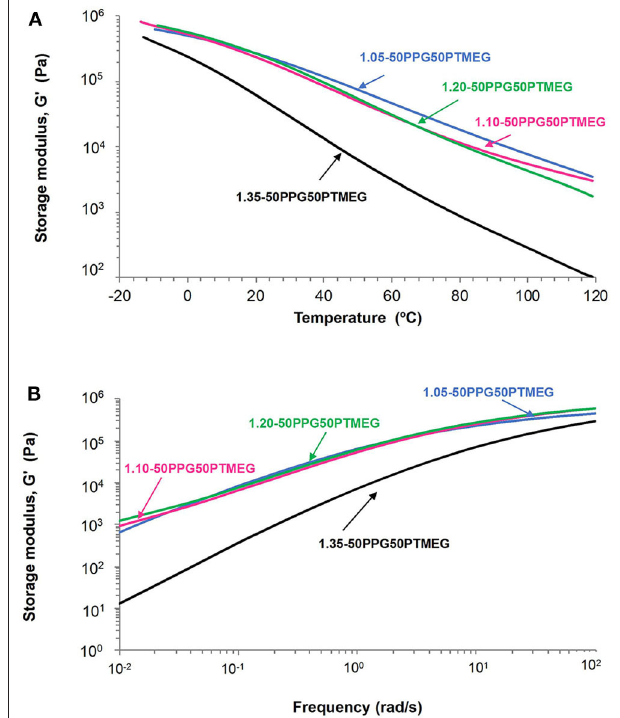
FIGURE 5 | (A) Variation of the storage modulus (G ′ ) as function of the temperature and (B) variation of the storage modulus (G ′ ) as a function of the frequency for TPUs synthesized with 50 wt% PPG + 50 wt% PTMEG blend and different NCO/OH ratios.